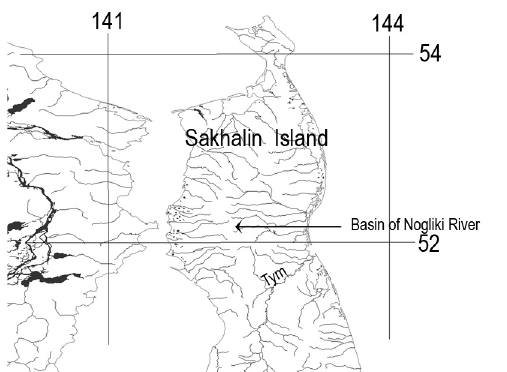
Fig. 18. Map of Churpuniya, Zimovie, Muksunikha-Tas, Khaar-Stan and Uryung-Khastakh Hills calving grounds.